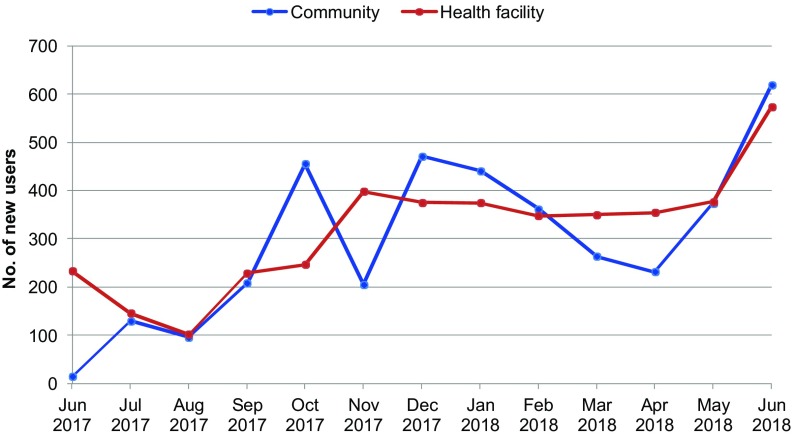
Number of New Users of DMPA-SC, by LocationAbbreviation: DMPA-SC, subcutaneous depot-medroxyprogesterone acetate.